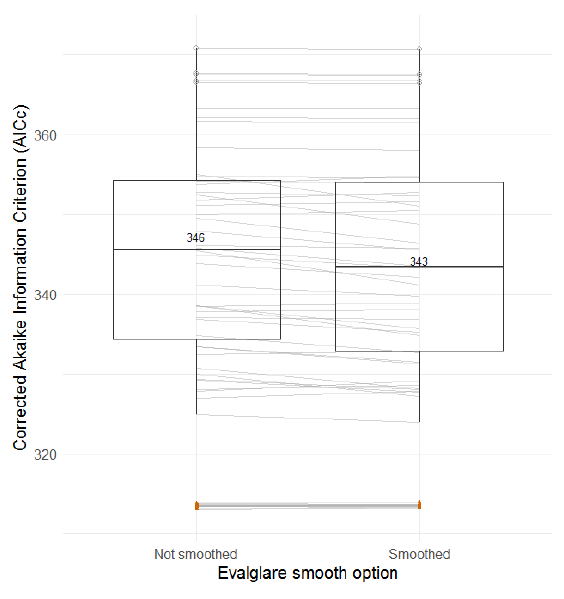
Figure 37. Boxplots of AICc for the non-smooth/smooth parameter (laboratory study).